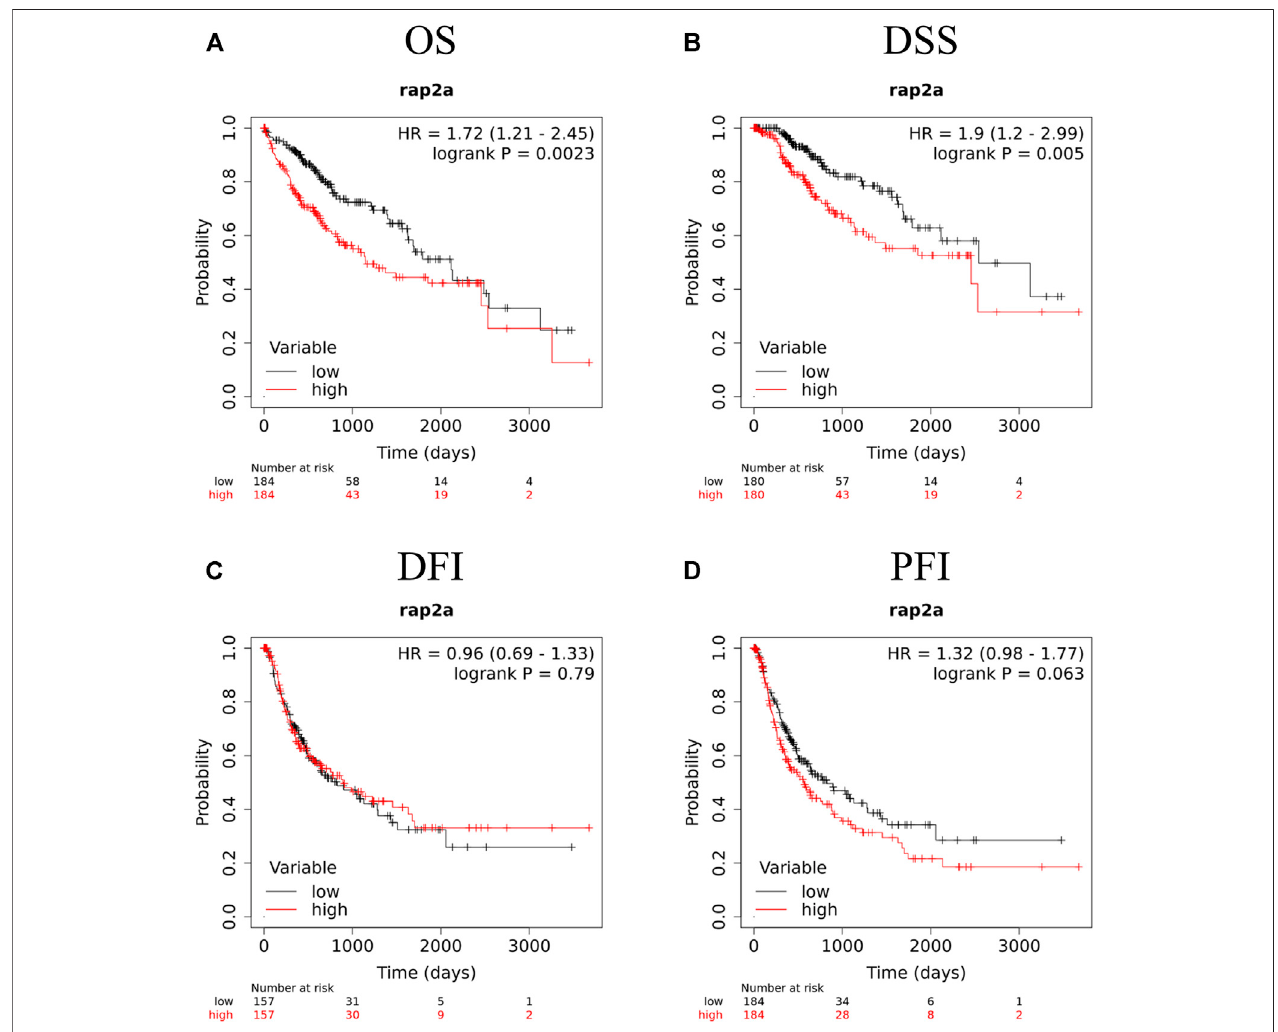
FIGURE 7 | Kaplan-Meier survival analysis of RAP2A in TCGA-LIHC dataset, including (A) OS, overall survival (B) DSS, disease speci fi c survival (C) DFI, disease free interval and (D) PFI, progression free interval. HR, hazard ratio; **** p < 0.0001; *** p < 0.001; ** p < 0.01; * p < 0.05; ns, p > 0.05.